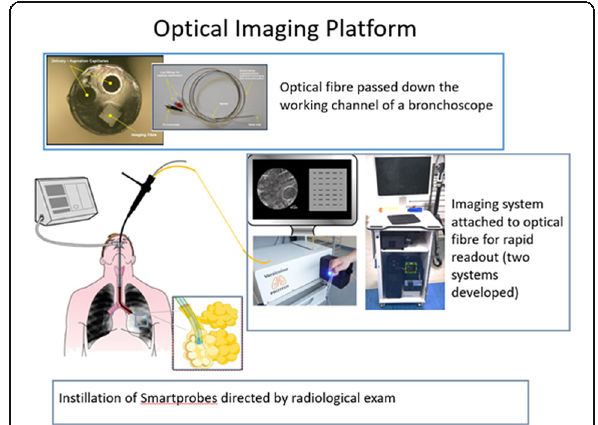
Fig. 1 Image showing a bronchoscopy procedure with the imaging fibre and capillary bundle being passed down the working channel of a bronchoscope into the alveolar regions. SmartProbes are delivered via the capillaries and images are sent via the imaging fibre to the imaging system at the patient ’ s